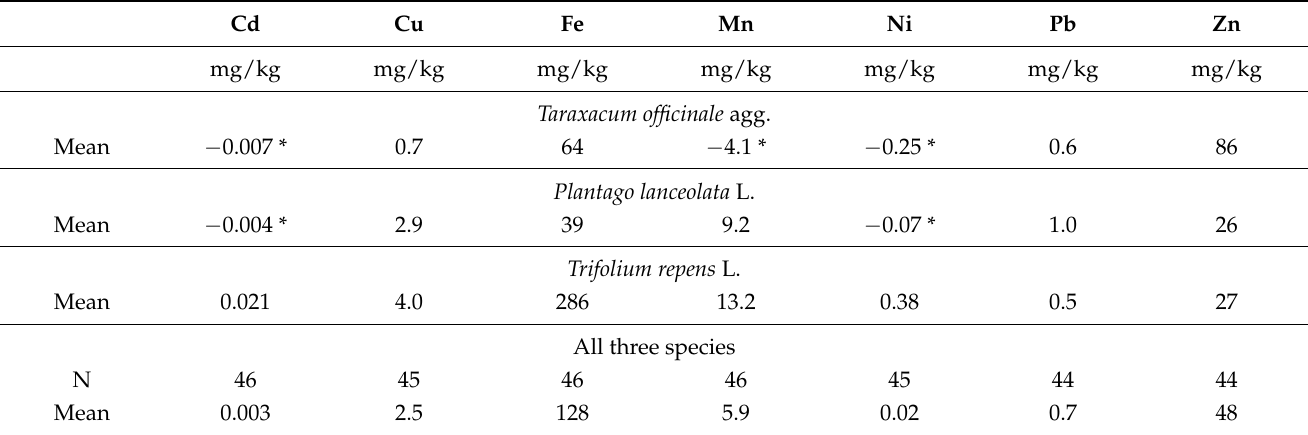
Table 3. Total mass of heavy metals (Cd, Cu, Fe, Mn, Ni, Pb and Zn) in dust deposited on the surface of Taraxacum officinale , Plantago lanceolata and Trifolium repens . The values given represent the difference between unwashed and washed plant samples.